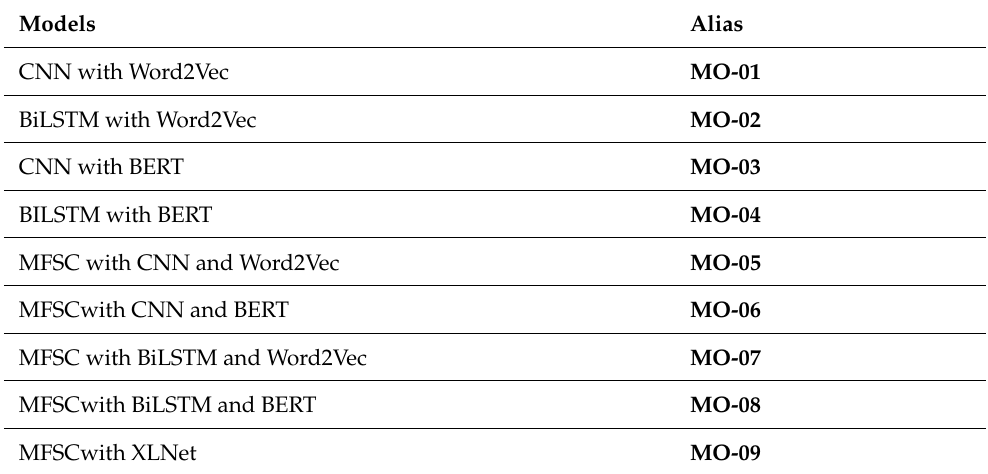
Table 4. The models and their